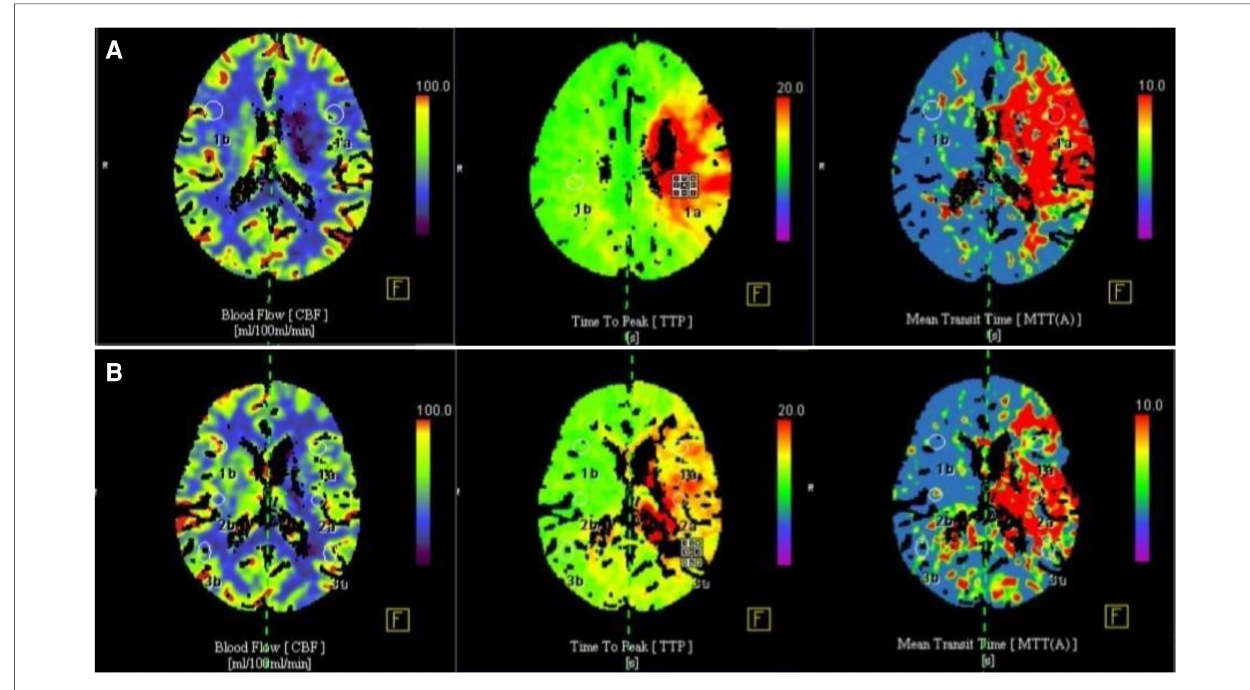
FIGURE 3 Comparison of CT cerebral perfusion parameters before and 3 months after surgery. ( A ) Preoperative cerebral blood fl ow was signi fi cantly reduced, CBF in cerebral perfusion CTP was signi fi cantly reduced, TTP and MTT were prolonged; ( B ) 3 months after operation, cerebral blood fl ow was signi fi cantly improved, CBF in cerebral perfusion CTP was increased, TTP and MTT time were signi fi cantly